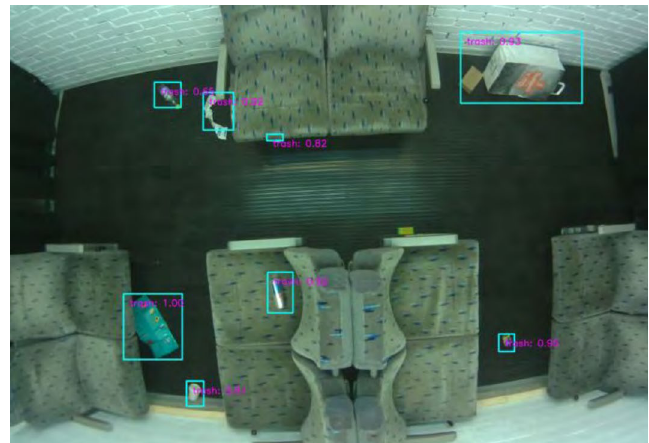
Fig. 1 Garbage detection in a lab replica of a metro. Source: Adapted from